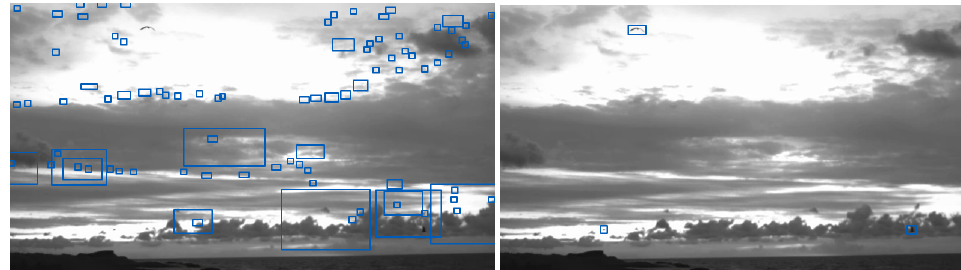
Figure 7. The effect of background and illumination variant on detection using computer vision based detector ( left ) and deep learning Model 3 ( right